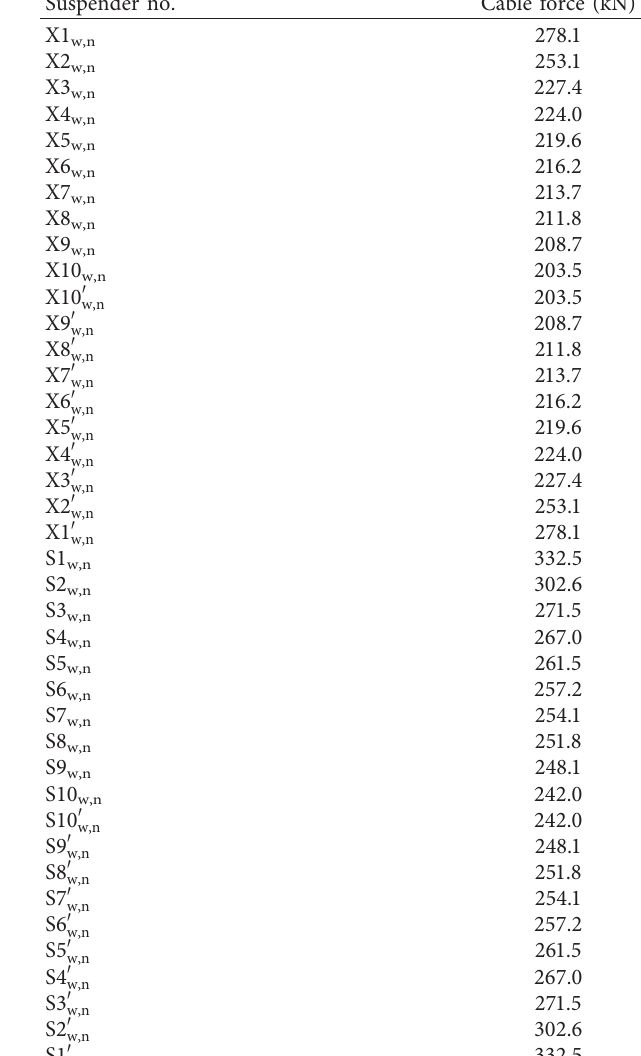
Table 2: Standard value of boom tension under dead load. Table 3: Standard value of boom tension under moving